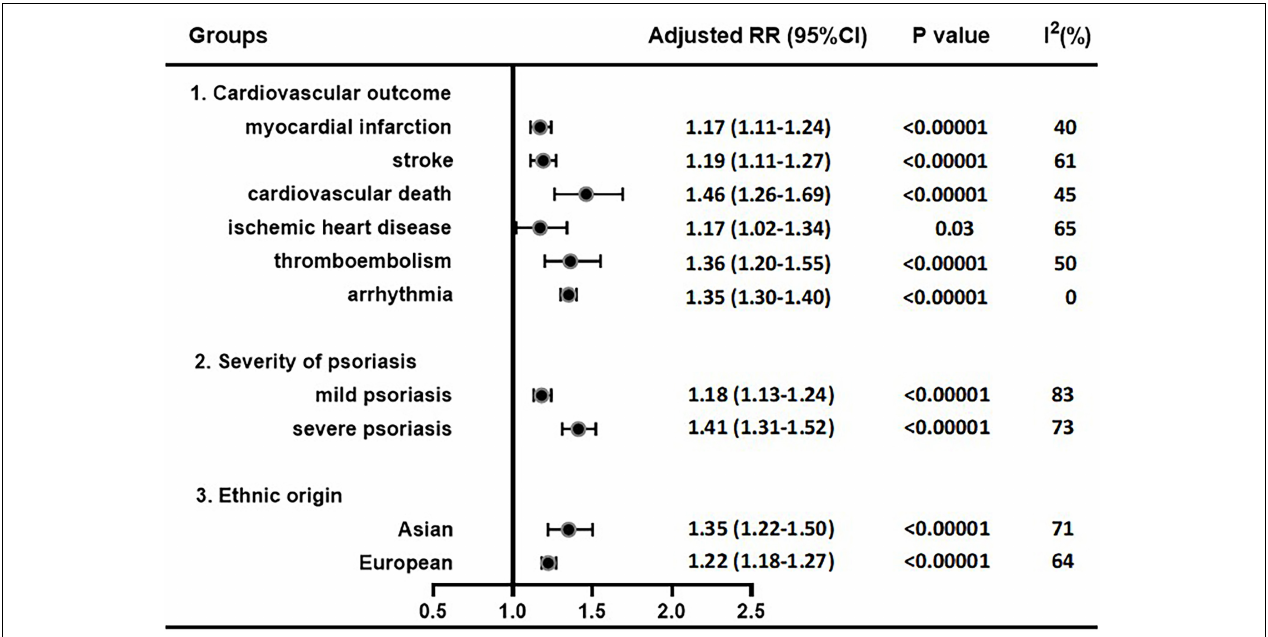
differences among these studies. After eliminating heterogeneity, the combined RR estimates were 1.20 (95% CI, 1.16–1.24)